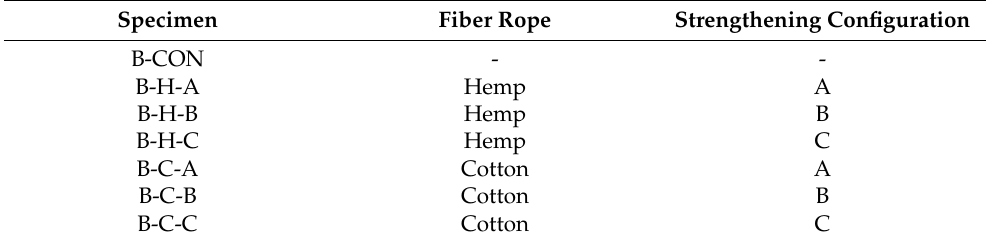
Table 1. Beam specimen designation.